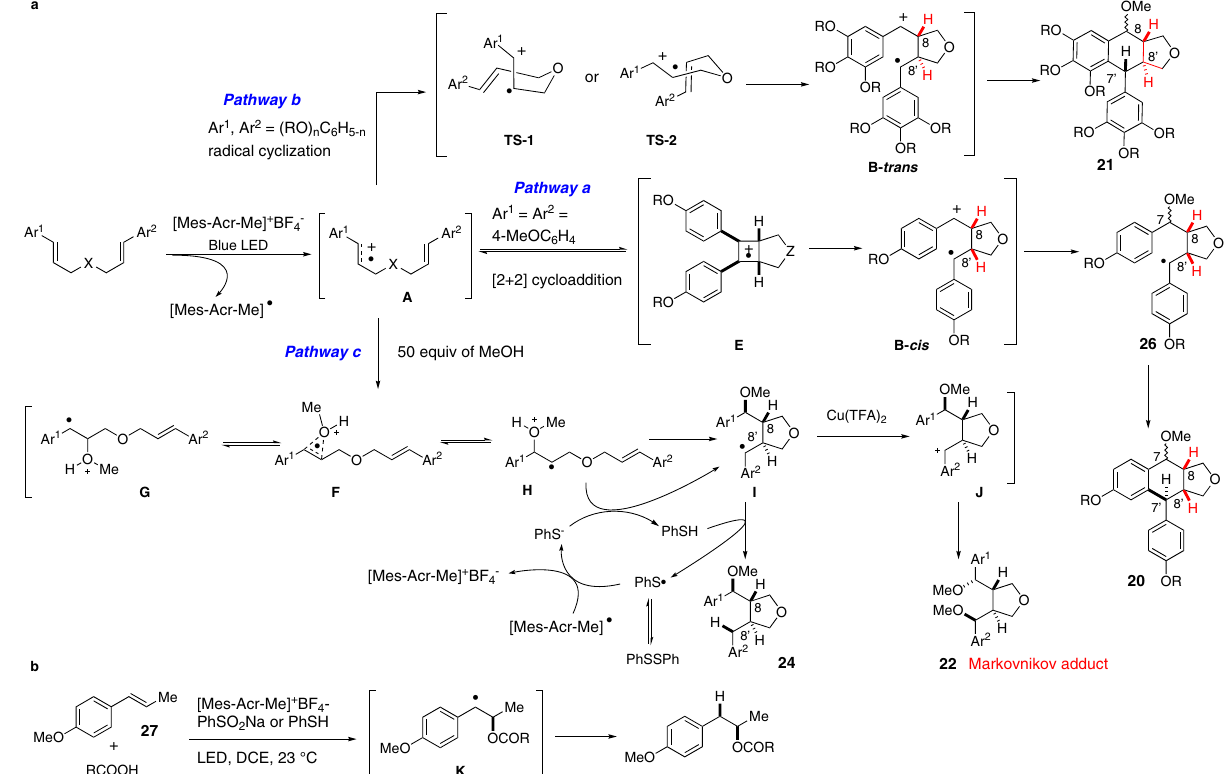
Fig. 9 Reaction pathways. a Divergent reaction pathways leading to different scaffolds of lignans; b anti -Markovnikov addition of carboxylic acid to